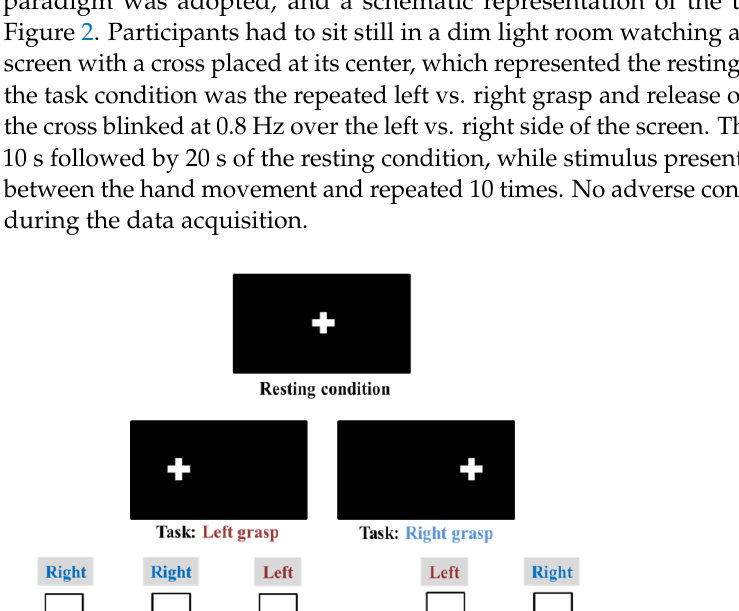
Figure 1. Employed fNIRS probe configuration in the current study. ( Left ) Red and green dots in- dicate the respective location of LED sources and fiber optics detectors according to the 10–10 refer- ence system labeling. ( Right ) Virtual co-registration of source (red dots) and detector (blue dots) locations over the Colin27 anatomical template in the AtlasViewer software package [45].